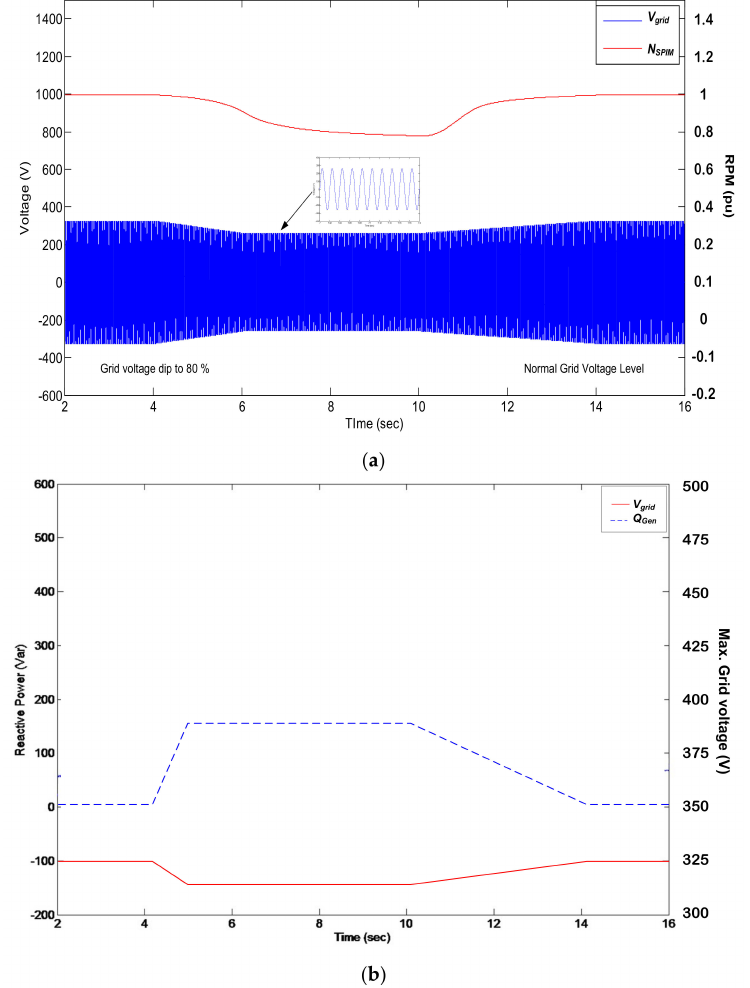
Figure 8. Operation of the proposed system to provide voltage support. ( a ) Speed of induction motor variation for voltage variation; ( b ) reactive power modification for voltage